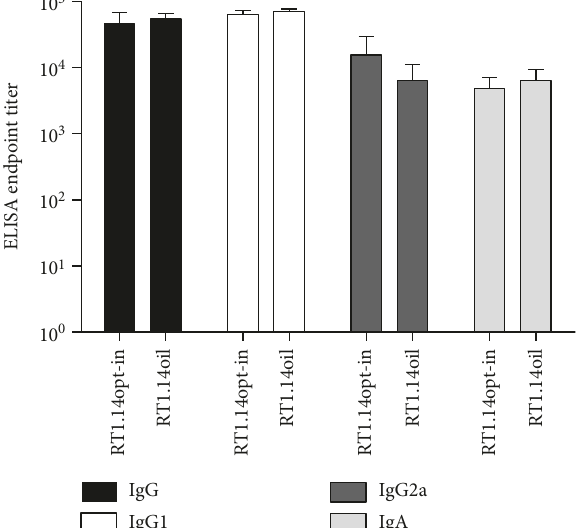
Figure 8: RT-speci fi c IgGs and IgA induced in sera of mice immunized with pVaxRT1.14opt-in and pVaxRT1.14oil plasmids. Endpoint titers of RT-speci fi c total IgG, IgG subtypes (IgG1, IgG2a), and IgA antibodies detected in the sera of BALB/c mice immunized with the genes encoding RT1.14opt-in and RT1.14oil plasmids. Data represent a mean +SD for the endpoint titer of antibodies against recombinant RT1.14 protein for four mice per group in two independent immunization runs. Cuto ff s were set against the control mice immunized with empty vector pVax1 (see “ Materials and Methods ” ). Groups demonstrate no signi fi cant di ff erence in either IgG, or IgG1, or IgG2a, or IgA levels ( p > 0 05 ).